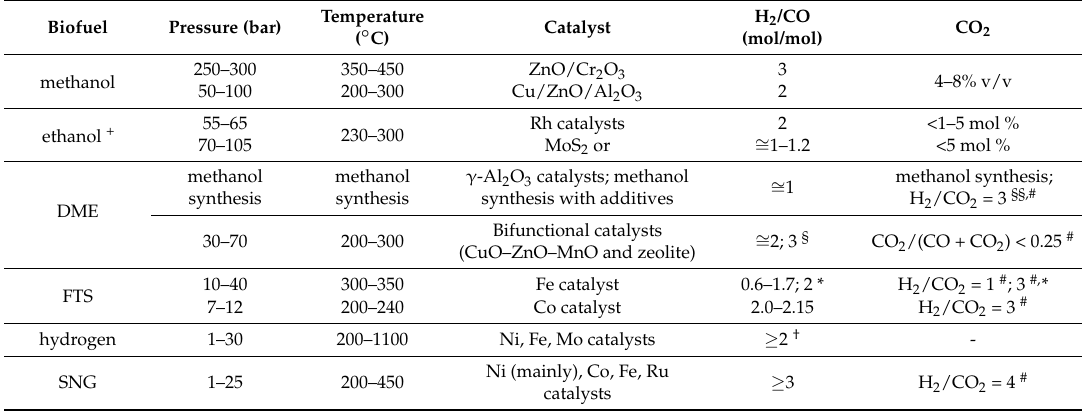
Table 9. Syngas conversion condition and syngas composition (H 2 /CO and CO 2 ) for different